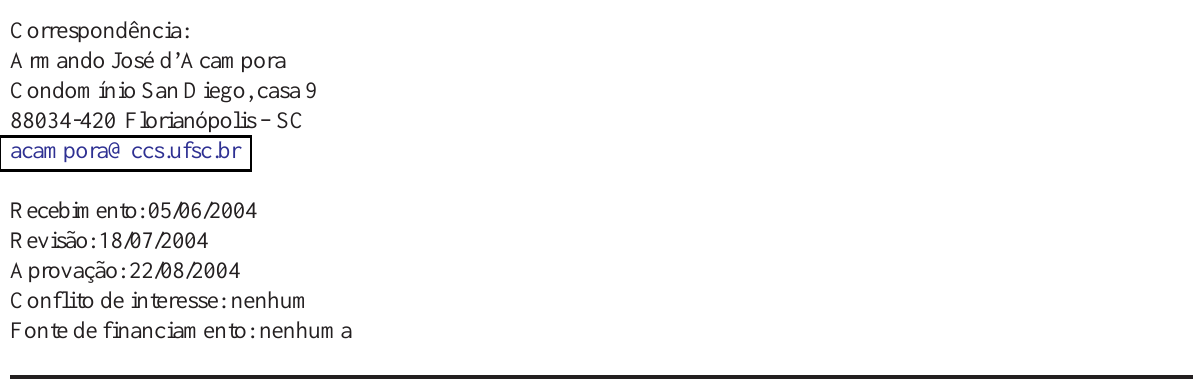
* Figuras coloridas disponíveis em